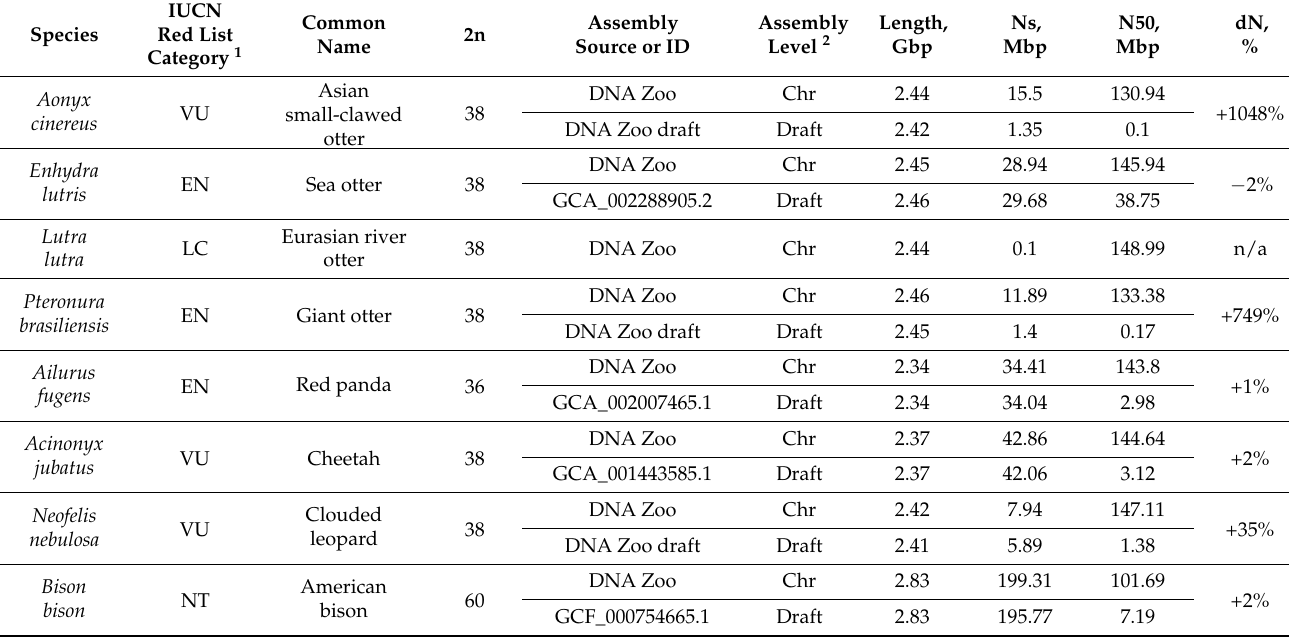
1 IUCN Red List categories: EN—endangered, VU—vulnerable, NT—near threatened, LC—least concern. 2 The assembly levels: draft— initial fragmented assembly, Chr—chromosome-level assembly based on draft and in situ high-throughput chromosome conformation capture